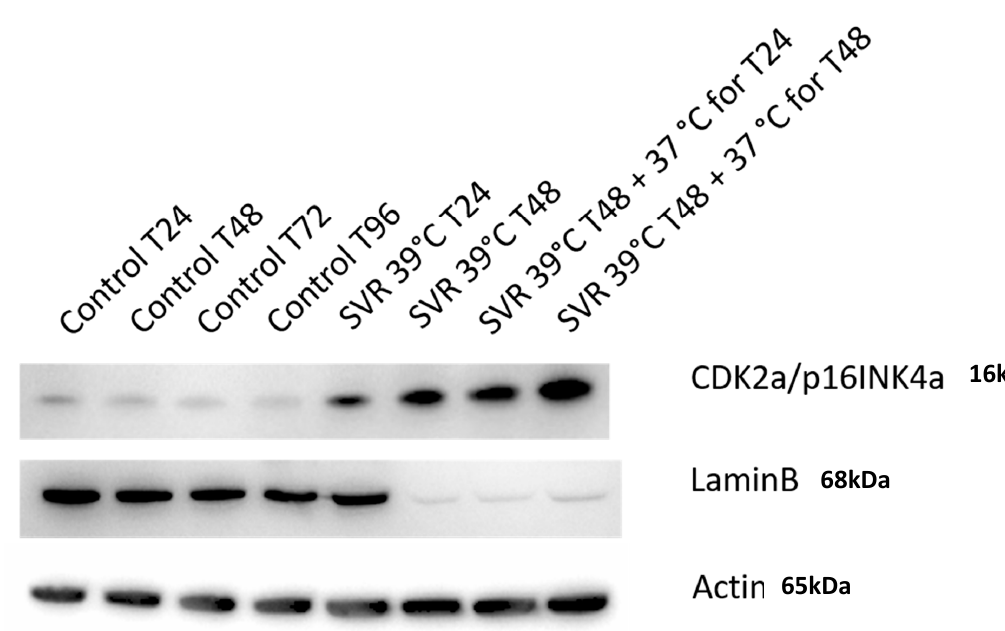
Figure 6. Western blot analysis conducted on SVR cells cultured at 37 ◦ C and 39 ◦ C (in 24 and 48 h), as in Figure 2, for evaluating a / p16INK4a and Lamin B. The continued elevation of p16ink4a